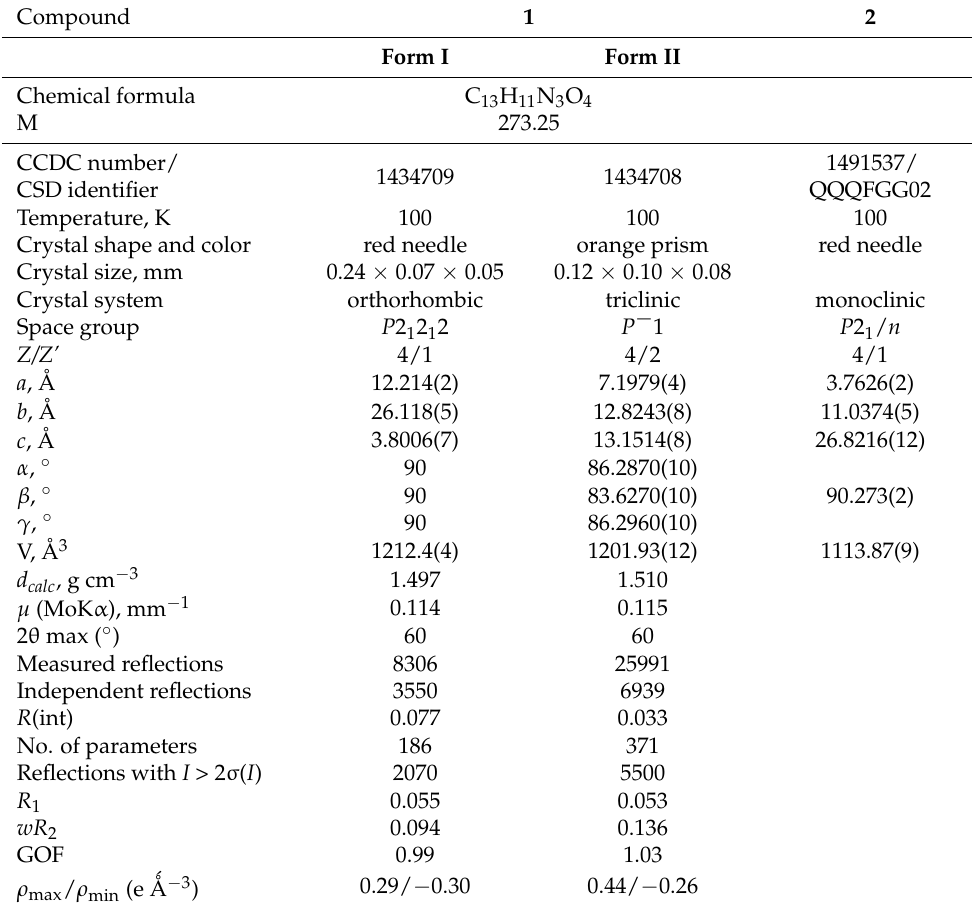
Table 1. Experimental crystallographic data and refinement parameters for polymorphs of 1 , forms I and II , and unit cell parameters of form 2